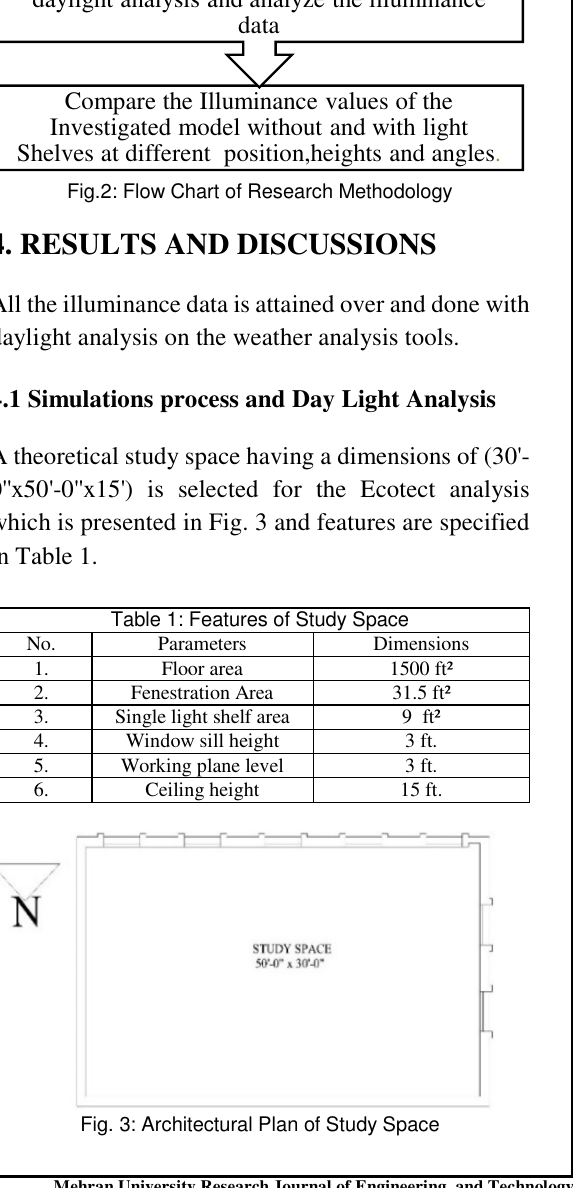
Fig. 3: Architectural Plan of Study Space